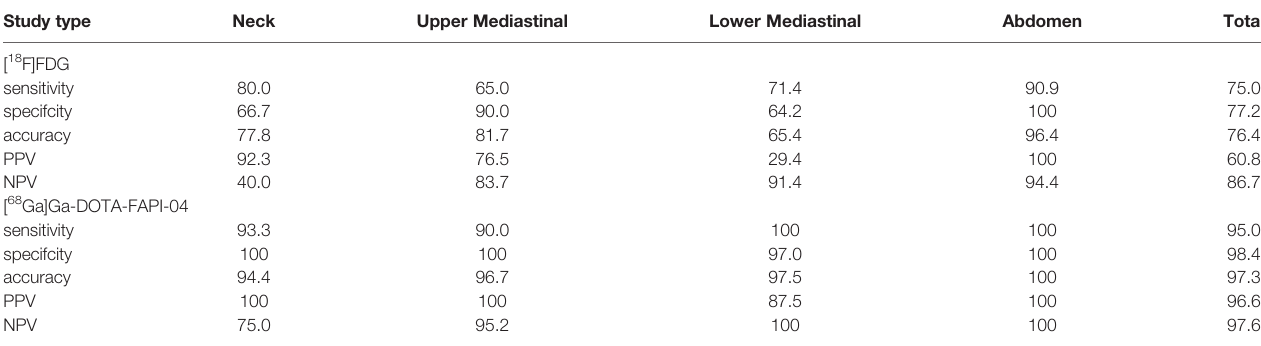
TABLE 3 | Diagnostic Performance of [ 68 Ga]Ga-DOTA-FAPI-04 and [ 18 F]FDG PET/CT in Assessment of Lymph Node Metastases. Study type